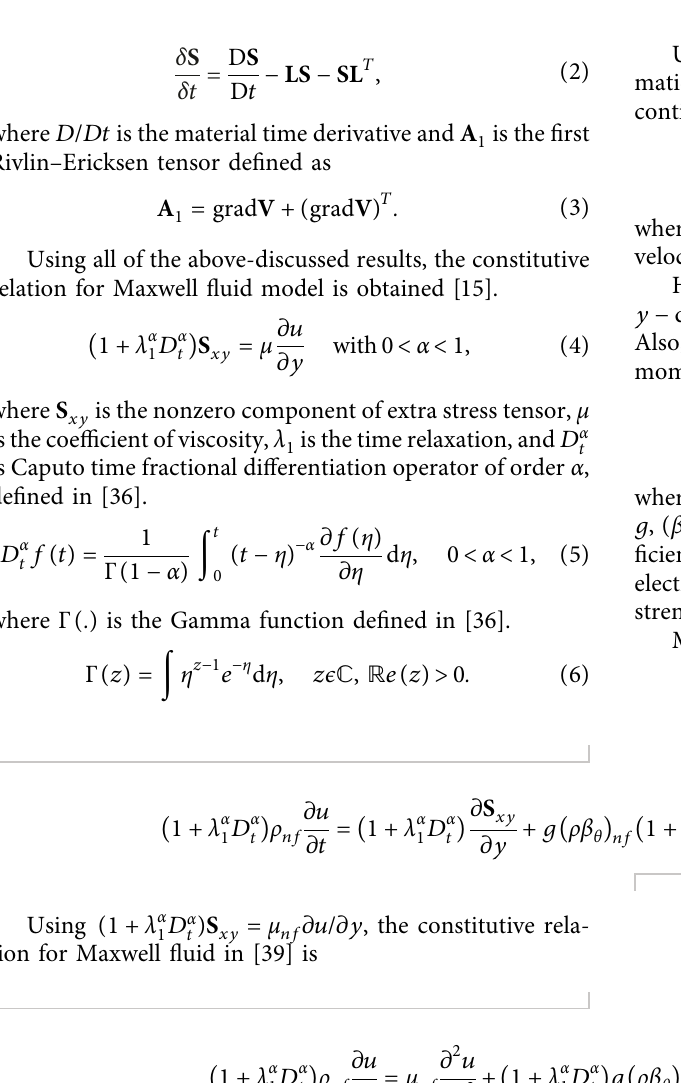
Figure 1: Geometry of the